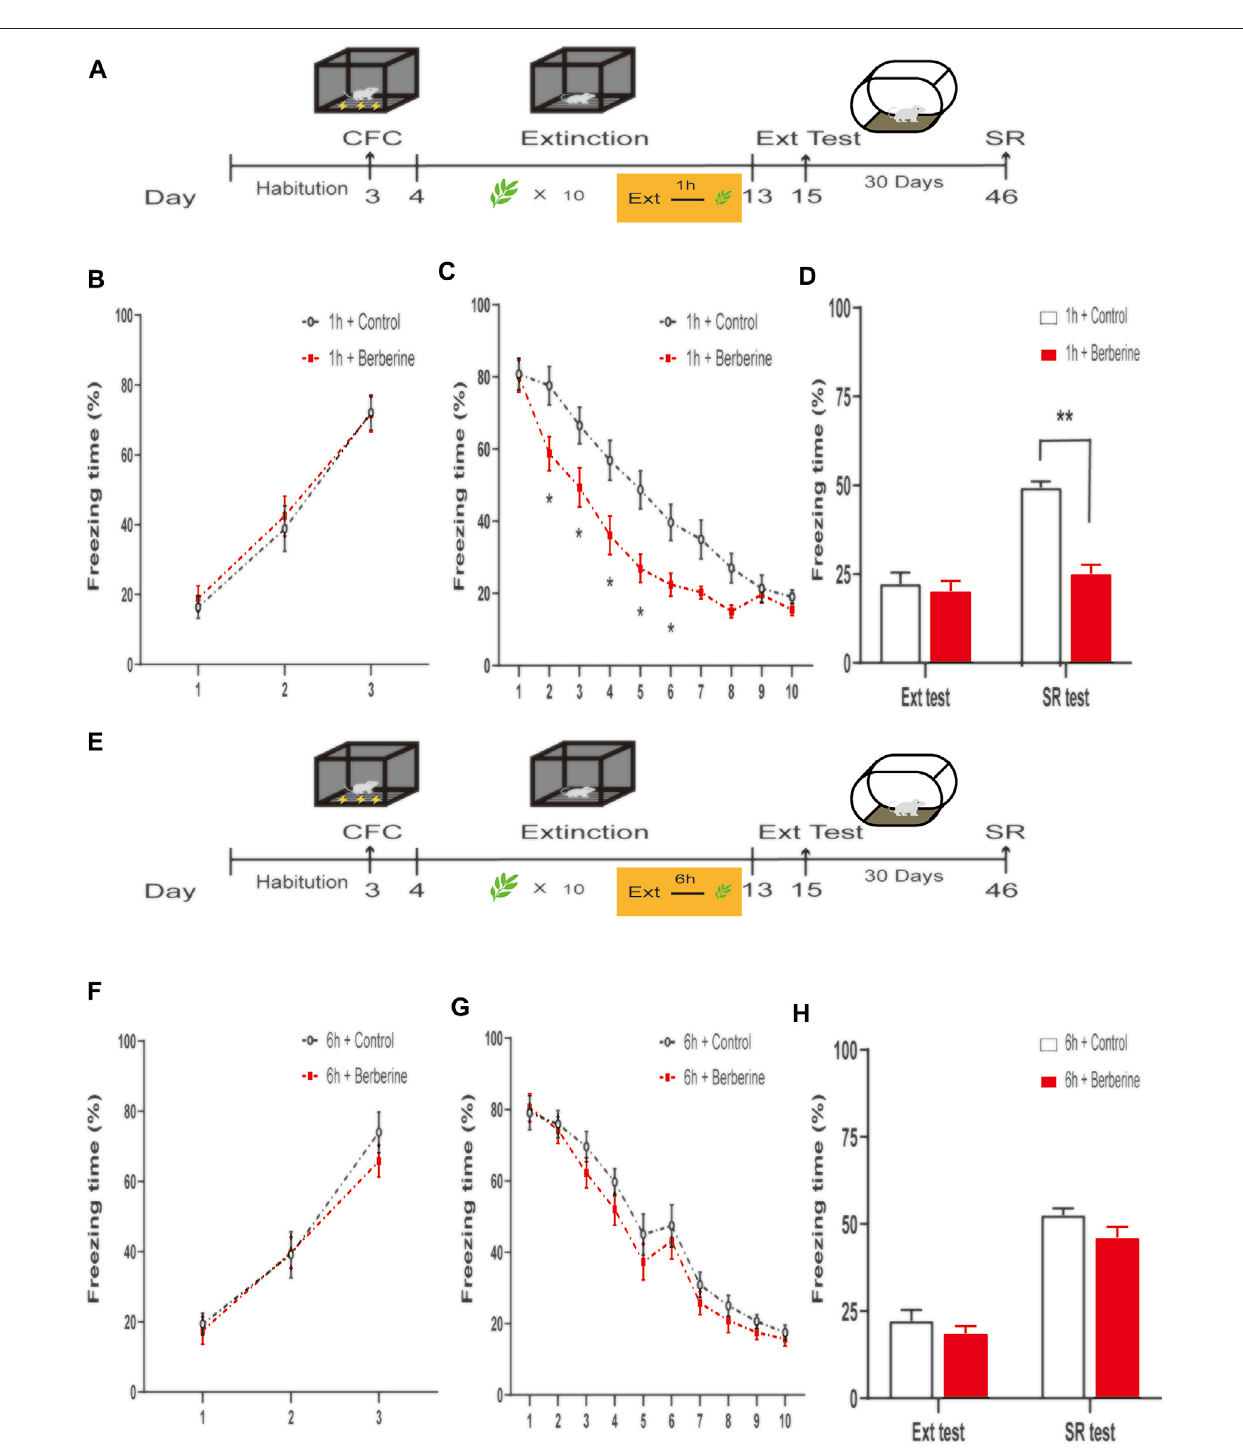
FIGURE 2 | Berberine administration 1 h after extinction enhanced extinction and reduced spontaneous recovery of recent fear. (A, E) Timeline of contextual fear conditioning, drug treatment, extinction training, extinction test, and spontaneous recovery test. (A) One hour or (E) 6 h after each extinction training session, corn oil (1 ml/kg, i.g.) or berberine (25 mg/kg, i.g.) was administered to mice, respectively. (B, F) Freezing levels during fear conditioning were similar between different groups. (C, G) Freezing behaviors declined during extinction training sessions. (C) Repeated-measures ANOVA, effect of the training day, F (9,117) = 169.3, p < 0.001; Bonferroni post hoc test, p < 0.05, during the extinction training days 2 – 6. (D, H) Percentage of freezing time during extinction test (left) and spontaneous recovery test (right). (D) Signi fi cantfreezingtimewasobservedinSRtest, p < 0.01. n =7 – 8micepergroup.Dataaremeans±SEM,* p < 0.05,** p < 0.01,comparedwith1 h+control group. CFC, contextual fear conditioning; Ext, extinction; SR, spontaneous recovery.